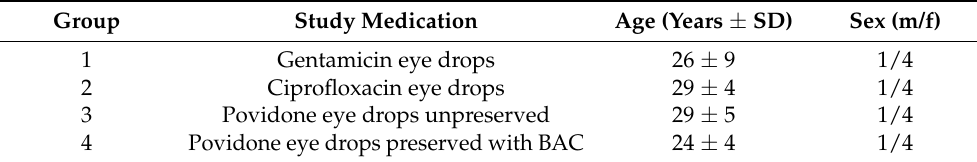
Table 1. Description of the four study groups ( n = 5 subjects/group). Group Study